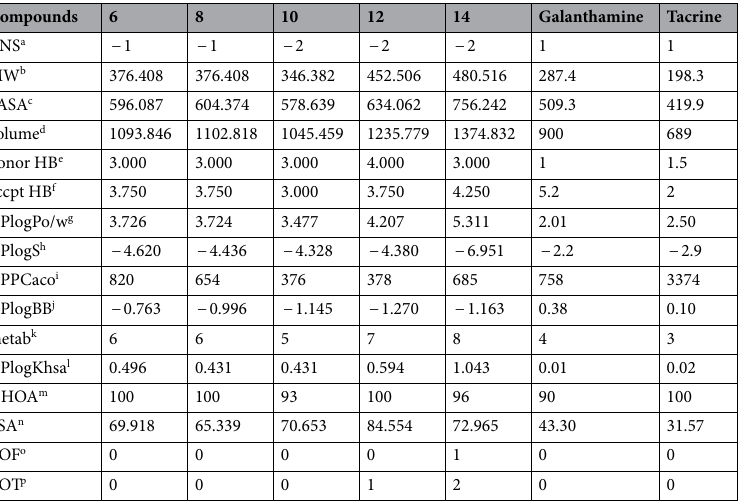
Table 2. ADME prediction results of five potent inhibitors (IC 50 BChE < 10 μM). a Predicted central nervous system activity (− 2–2). b Molecular weight of the molecule (130–725). c Total Solvent Accessible Surface Area, in square angstroms, using a probe with a 1.4 Å radius (300.0–1000.0). d Total solvent-accessible volume, in cubic angstroms, using a probe with a 1.4 Å radius (500.0–2000.0). e Estimated number of hydrogen bonds that would be donated by the solute (0.0–6.0). f Estimated number of hydrogen bonds that would be accepted by the solute (2.0–20.0). g Predicted octanol/water partition coefficient (− 2.0–6.5). h Predicted aqueous solubility (− 6.5–0.5). i Predicted apparent Caco-2 cell (a model for the gut-blood barrier) permeability in nm/sec (< 25 poor, > 500 great). j Predicted brain/blood partition coefficient (− 3.0–1.2). k Number of primary metabolites (1–8). l Prediction of binding to human serum albumin (− 1.5–1.5). m Predicted qualitative Human Oral Absorption (> 80% is high, < 25% is poor). n Van der Waals surface area of polar nitrogen and oxygen atoms (7.0–200.0). o Number of violations of Lipinski’s Rule of Five (molecular weight < 500, QPlogPo/w < 5, number of hydrogen bond donor < 5, number of hydrogen bond acceptors HB < 10). p Number of violations of Jorgensen’s rule of three (QPlogS > − 5.7, QPCaco > 22 nm/s, number of primary metabolites <